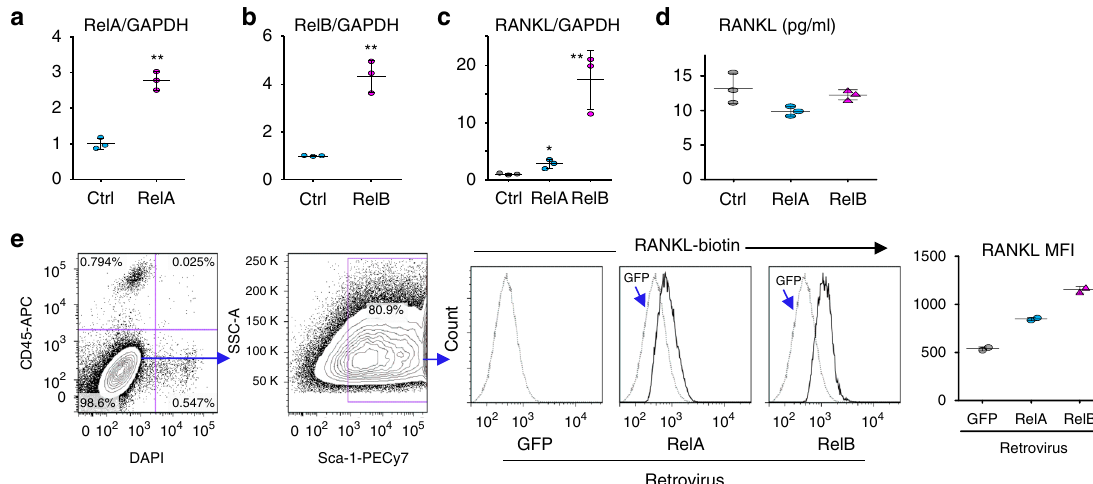
Fig. 6 RelA and RelB increase RANKL expression by MPCs. Calvarial pre-osteoblasts from 7-day-old WT mice were infected with GFP control, RelA, or RelB retroviruses for 48 h. a RelA and b RelB mRNA expression tested by real-time PCR to con fi rm successful over-expression. Mean± SD ( n = 3 biologically